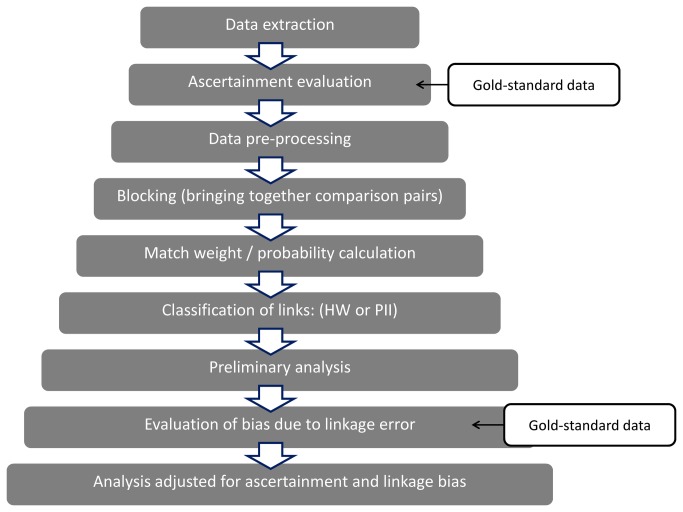
Steps involved in linkage of PICANet and LabBase2 for enhanced BSI surveillance in PICU.